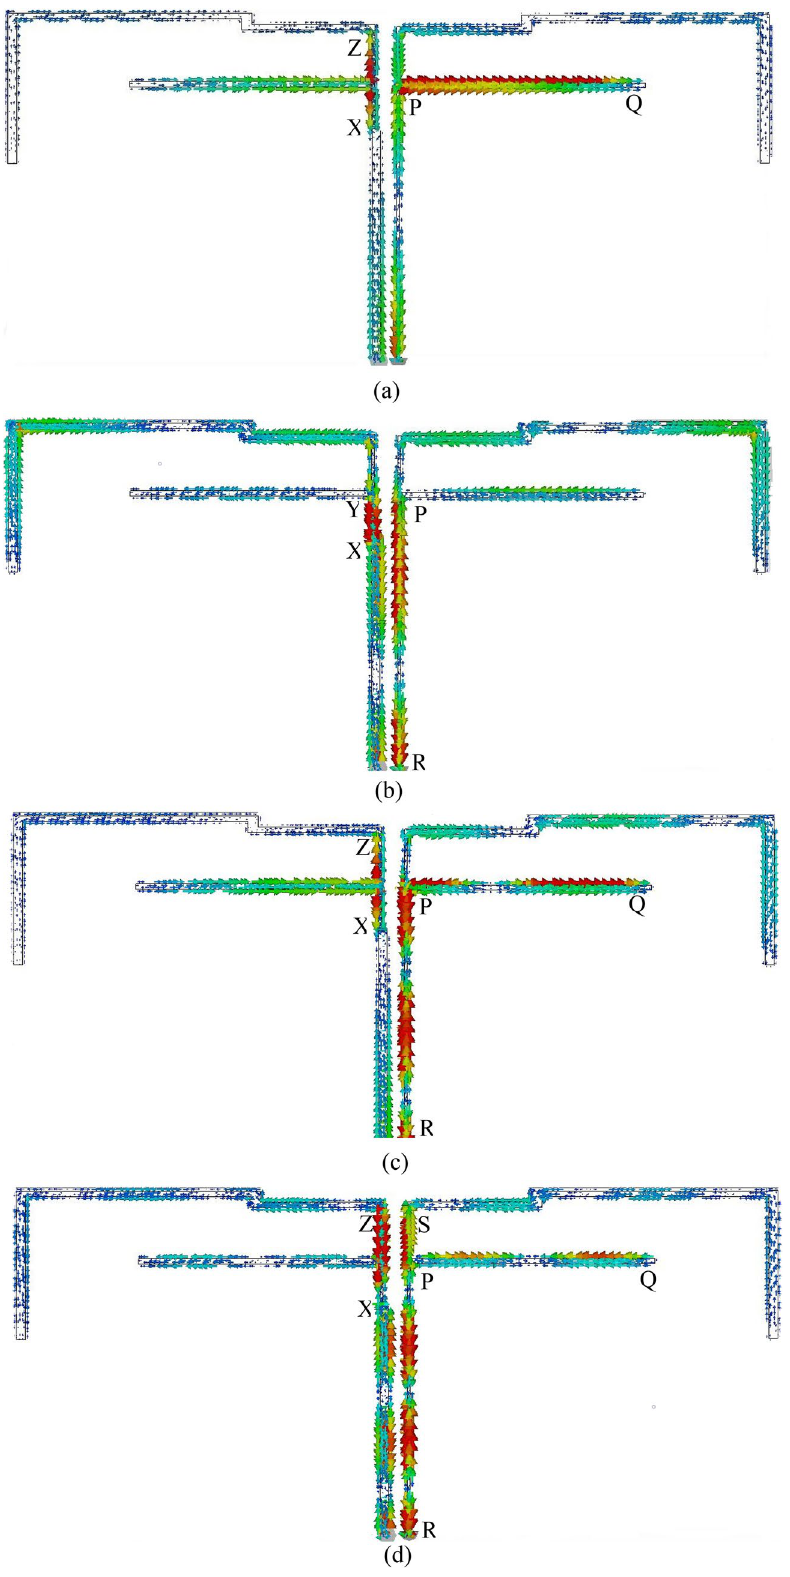
Figure 4. Surface current distributions at ( a ) 863 MHz, ( b ) 1.51 GHz, ( c ) 2.25 GHz, ( d ) 3.11 GHz, ( e ) 3.65 GHz, ( f ) 4.25 GHz, ( g ) 5.59